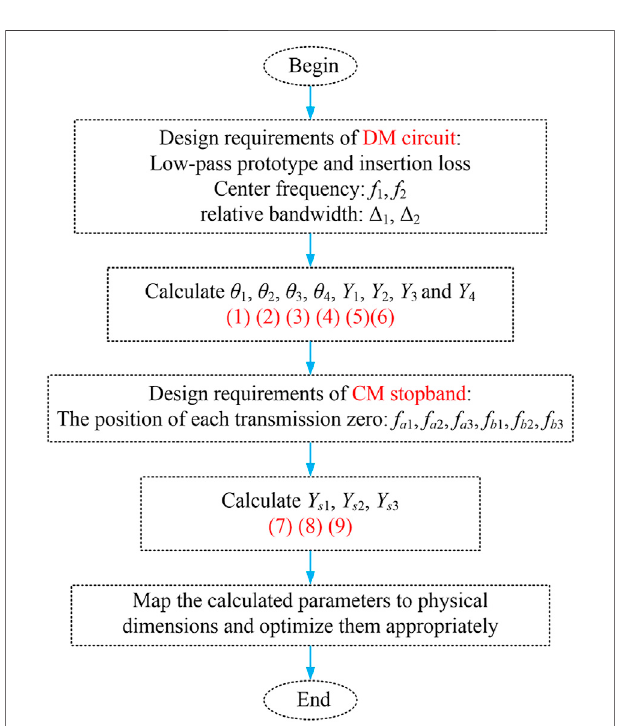
FIGURE 10 | The design process of the proposed balanced fi lter.